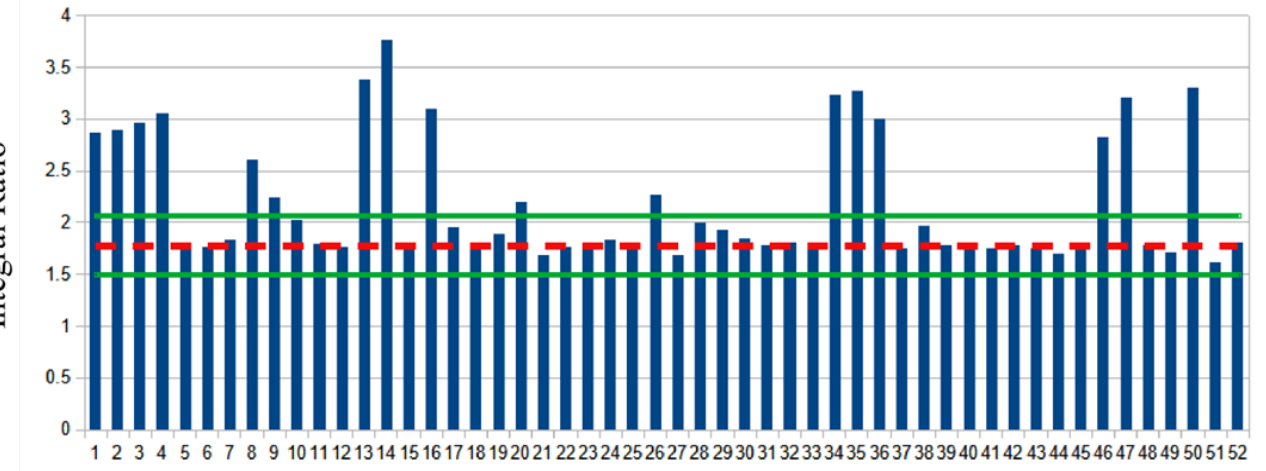
Figure 2. Unsaturated bond to glycerol C2 proton ratio of market survey samples. The mean ratio of baseline samples is depicted with a dashed red line, green lines are the mean plus or minus two standard deviations.